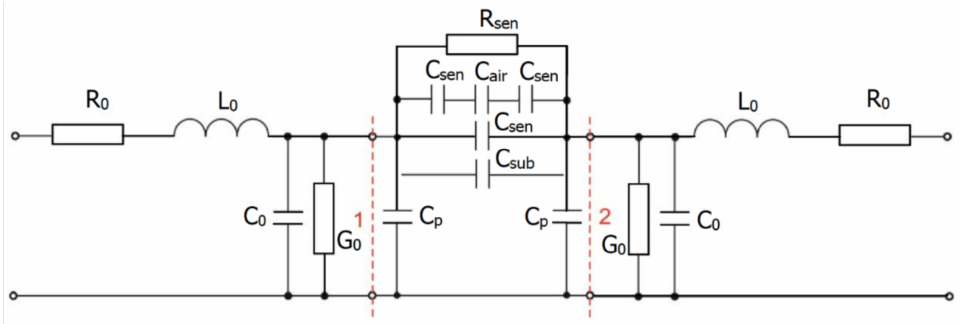
Figure 2. Equivalent circuit of the measuring